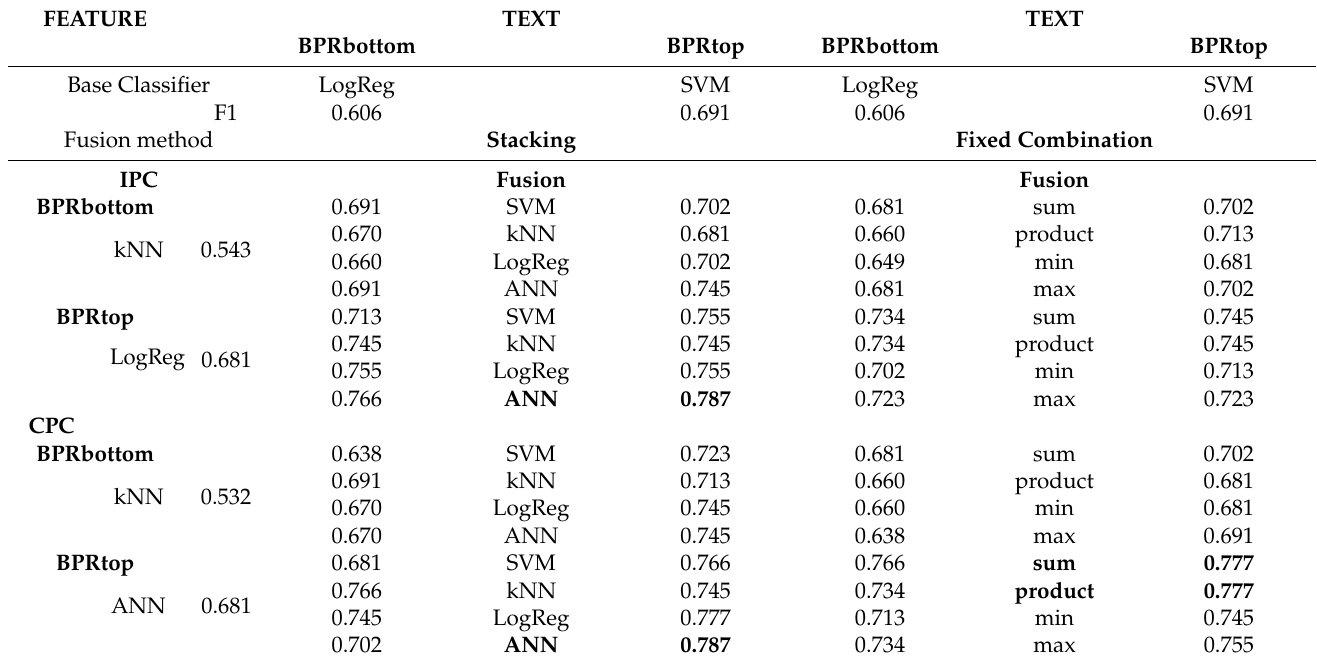
Table 5. Resulting performance (F1) of the ensemble classification displayed as pivot table of different base classifiers combinations using stacking or fixed combinations rules as fusion method. The combination of the base learners in pairs of one text and one taxonomic (either IPC or CPC) classifier is additionally varied according to the Base Performance Ranking (BPR: top or bottom rank). For each of those conditions four different stacking classifiers as well four fixed-combinations rules are applied (see Table 4). Peak values are printed in bold.